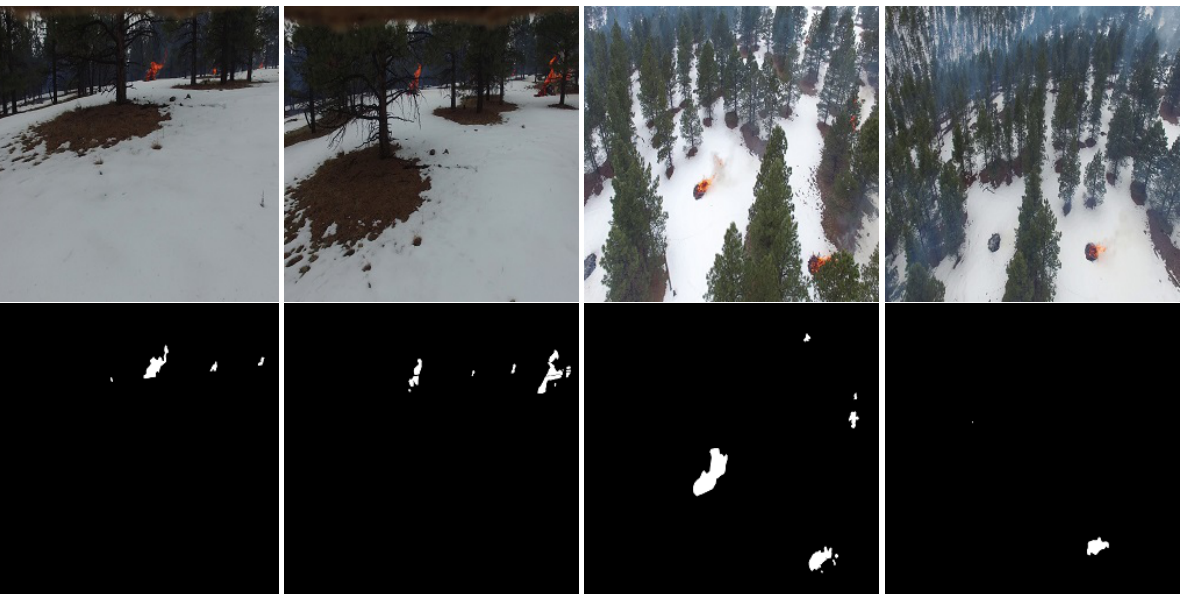
Figure 6. Examples from the FLAME dataset. ( Top ): Fire images; ( Bottom ): non-fire images.